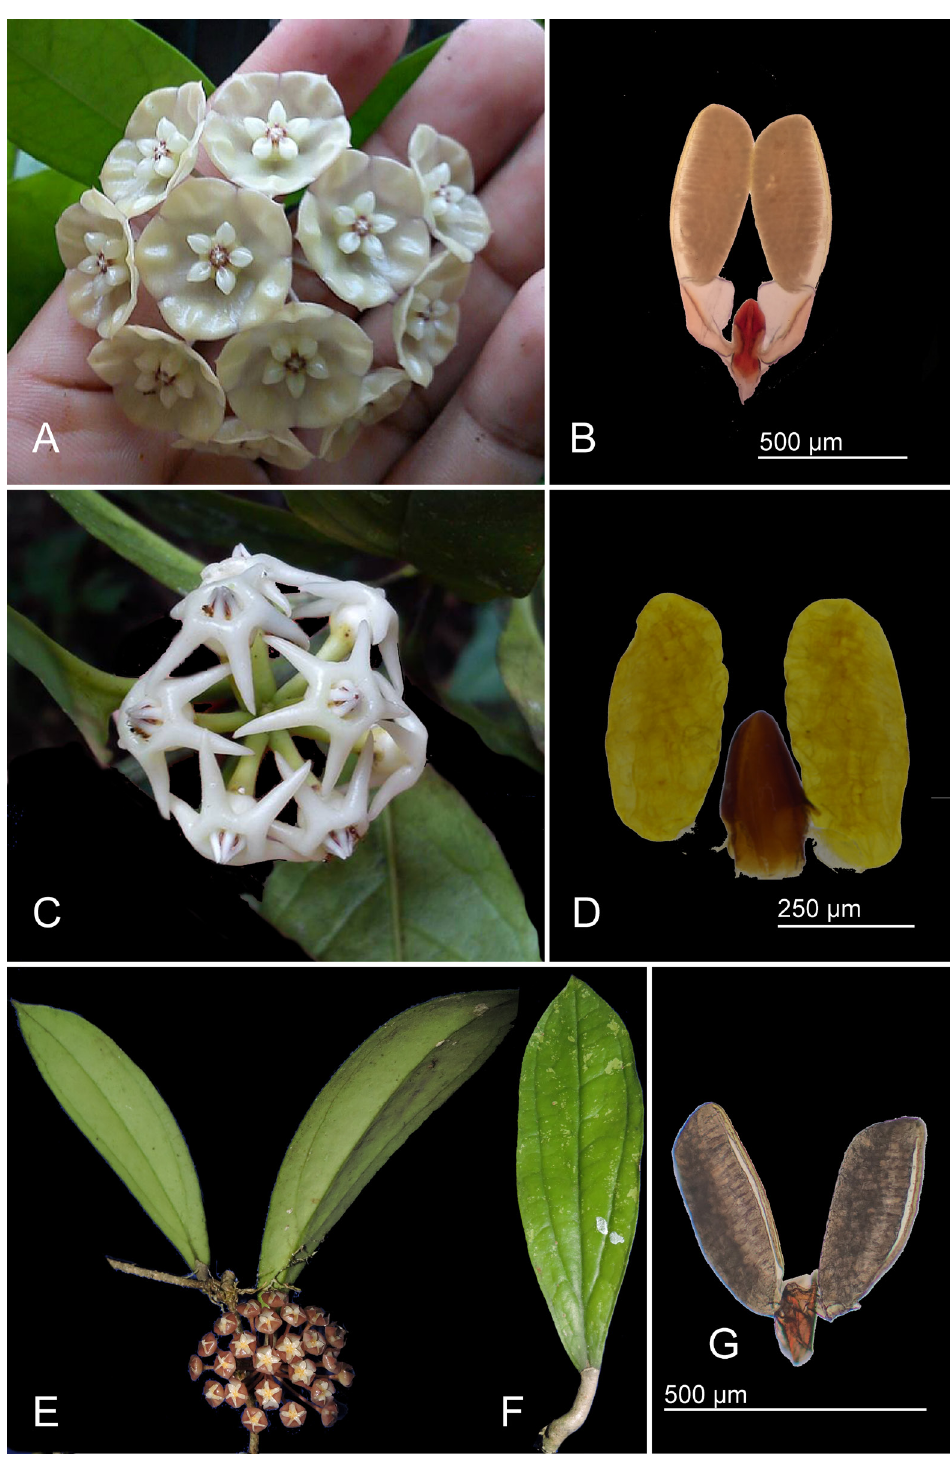
Fig. 2. Inflorescence, pollinarium, and leaf. A , C , E . Inflorescences. B , D , G .